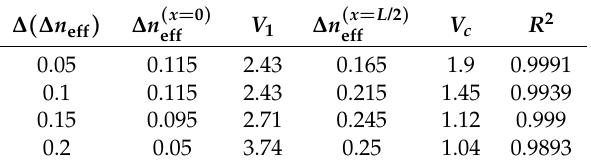
Table 3. Results of the optimization process to obtain parabolic phase profiles with parabola-shaped